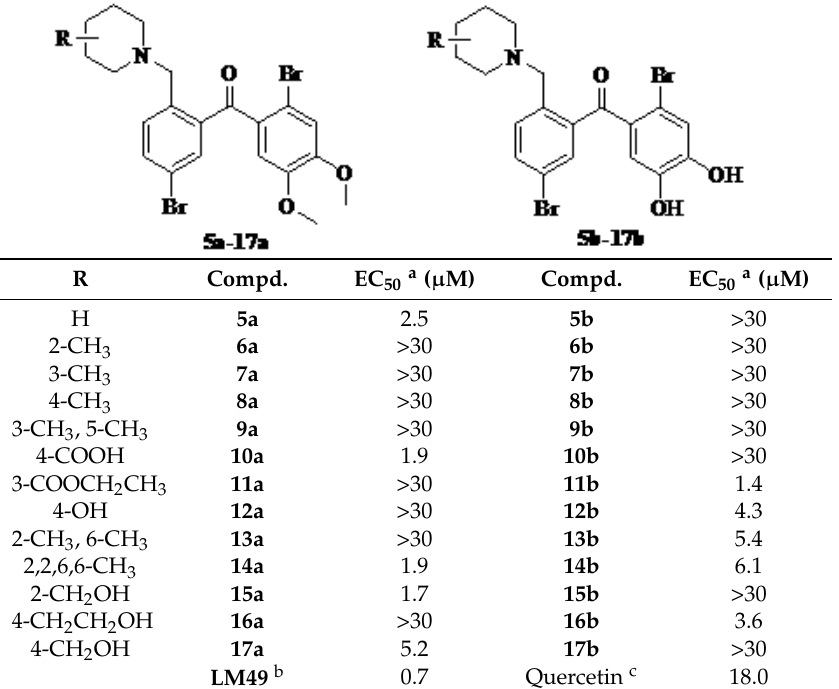
Table 1. Structures of piperidine compounds 5a–17a , 5b–17b and their cytoprotective activity against H 2 O 2 induced injury in EA.hy926 cells.